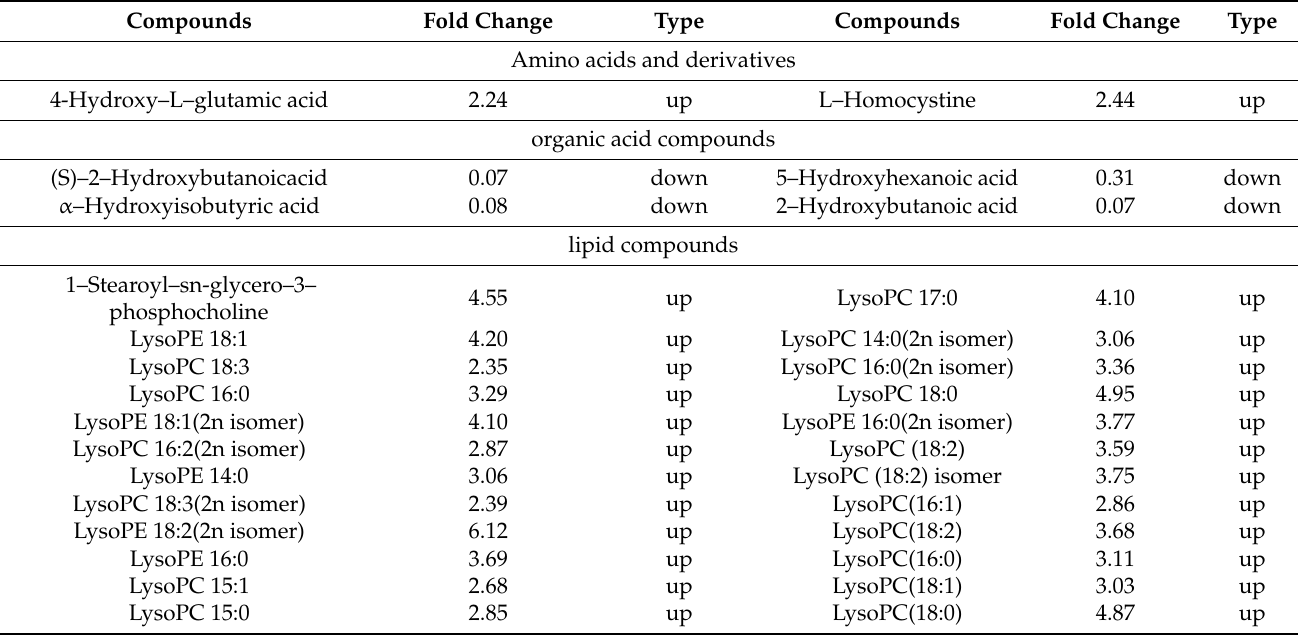
Table 2. Representative differential primary metabolites.